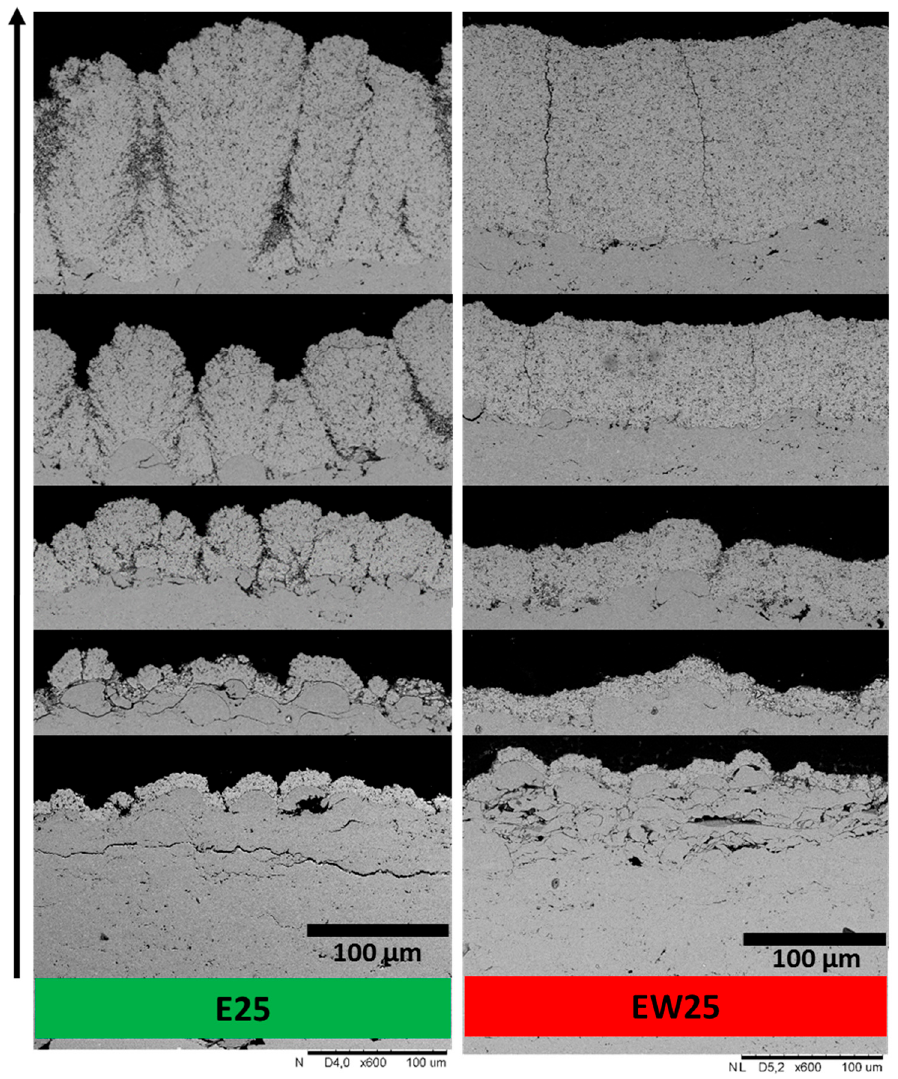
Figure 8. Evolution of SPS YSZ microstructure using an ethanol (E25) and ethanol–water (EW25) based suspensions with identical solid loading of 25 wt. %. The former leads to a columnar coating and the latter to a dense vertically cracked coating [49].